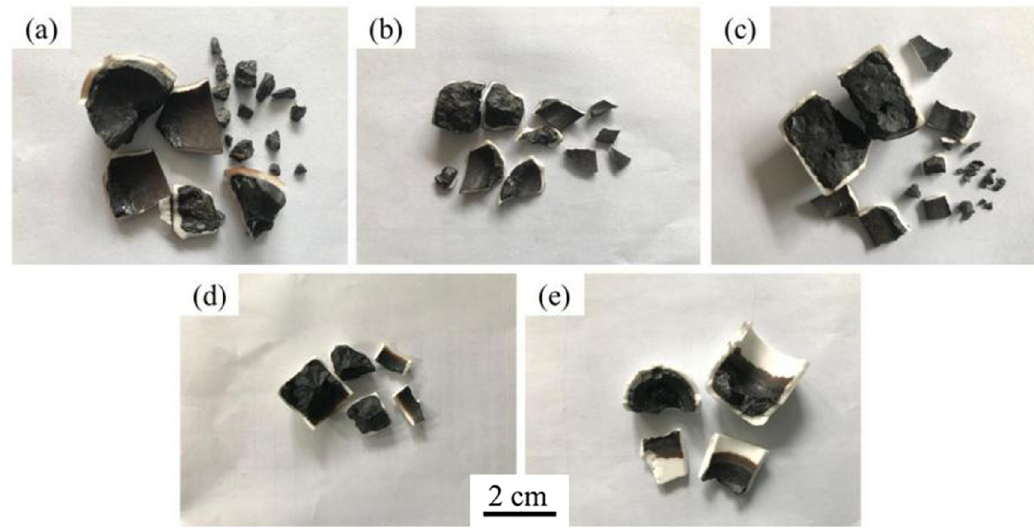
Figure 4: Roasting of mixed slag with di ff erent basicities at 1,450°C: ( a ) R = 1.6; ( b ) R = 1.8; ( c ) R = 2.0; ( d ) R = 2.2; ( e ) R =